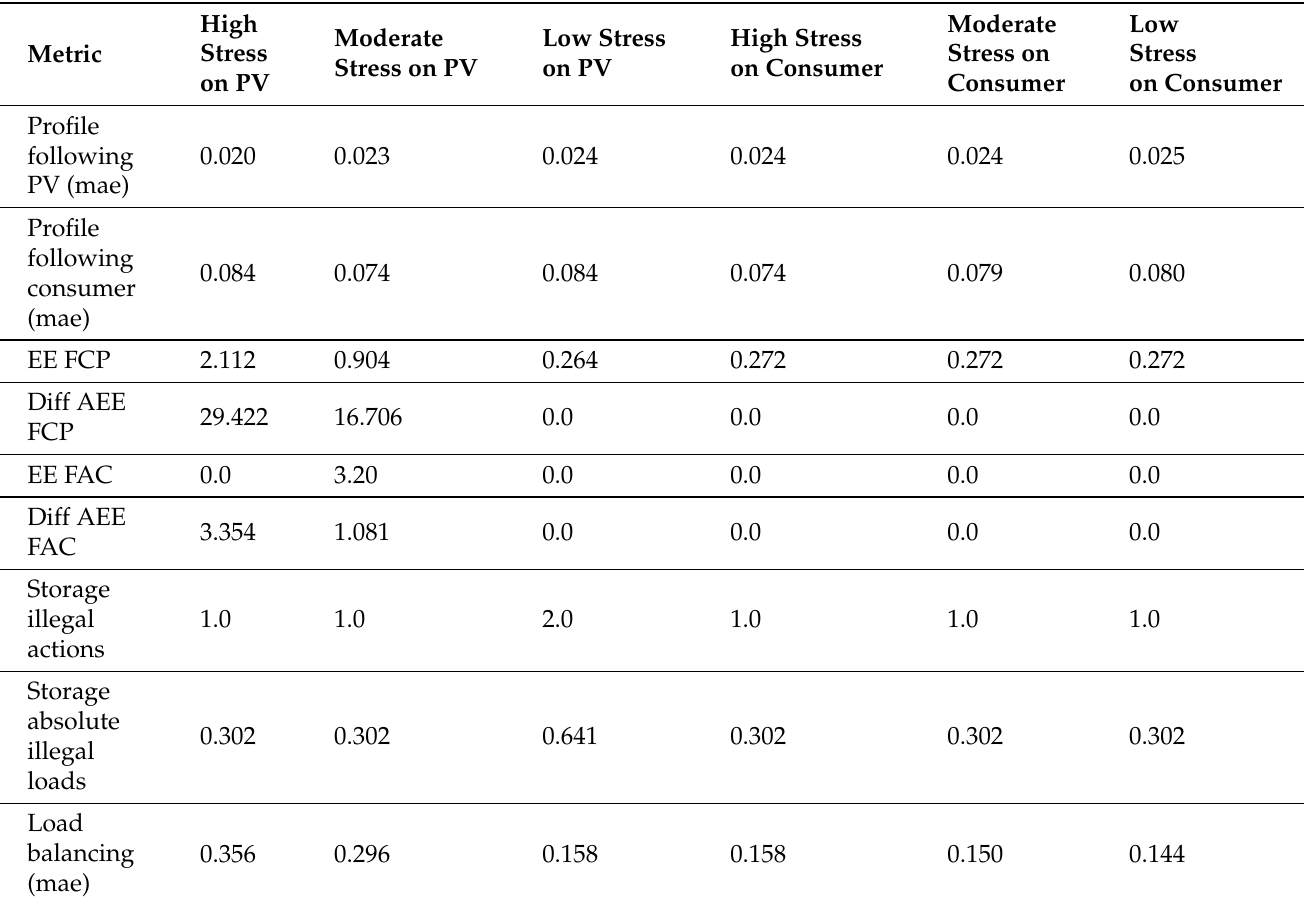
Table 10. Generalised training, evaluation on day 1 with the stressors switched